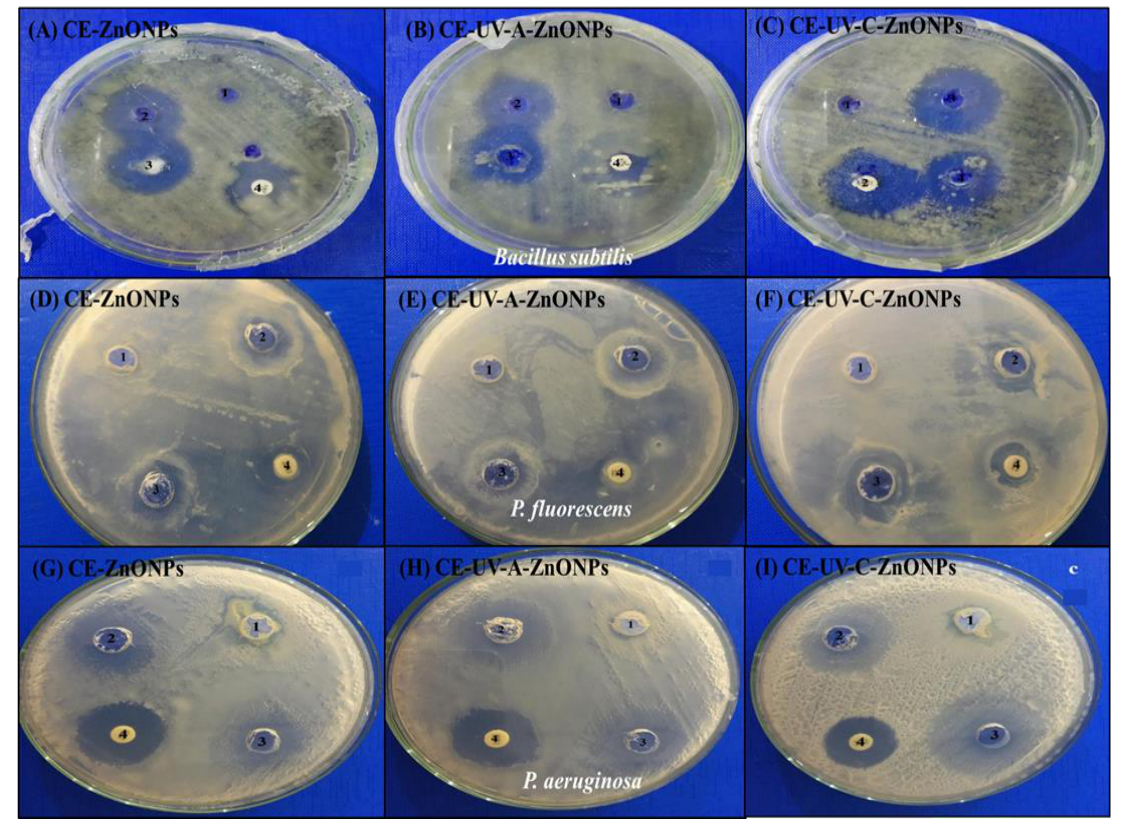
Figure 6. Antibacterial activity of ZnONPs against ( A – C ) B. subtilis, ( D – F ) P. fluorescens ( G – I ) P. aeruginosa . In each petri plate, well 1 contains Casuarina equisetifolia leaf extract, well 2 contains zinc acetate, well 3 contains ZnONPs and well 4 contains an ampicillin disc. Table 1. Zone of inhibition of green-synthesized ZnONPs against different bacterial